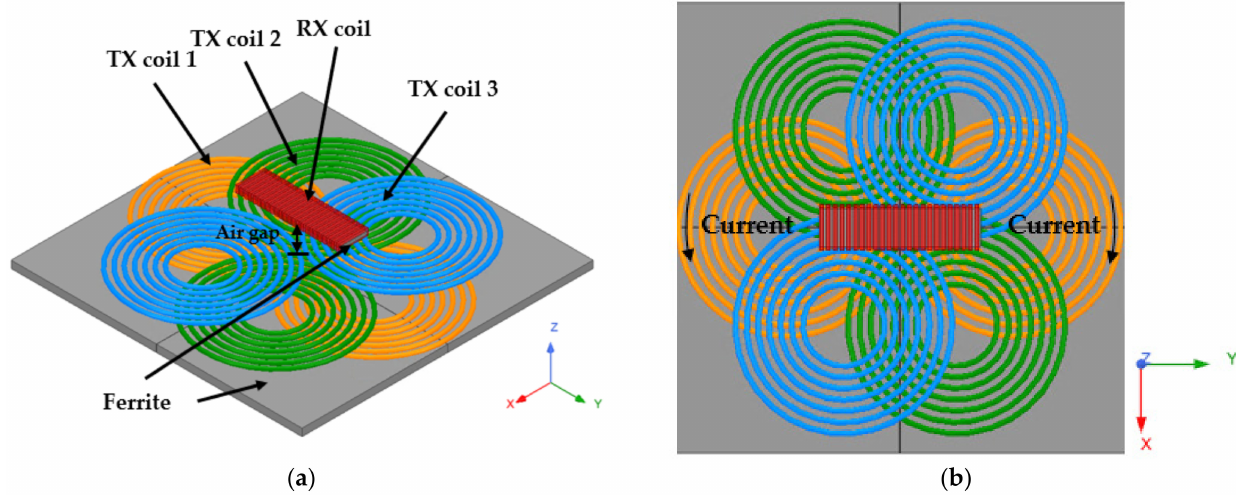
Figure 1. Design of the proposed models for WTT and WPT. ( a ) Perspective view; ( b ) Top view. Three TX coils are stacked at intervals of 60 degrees. RX coil is wound in the form of a